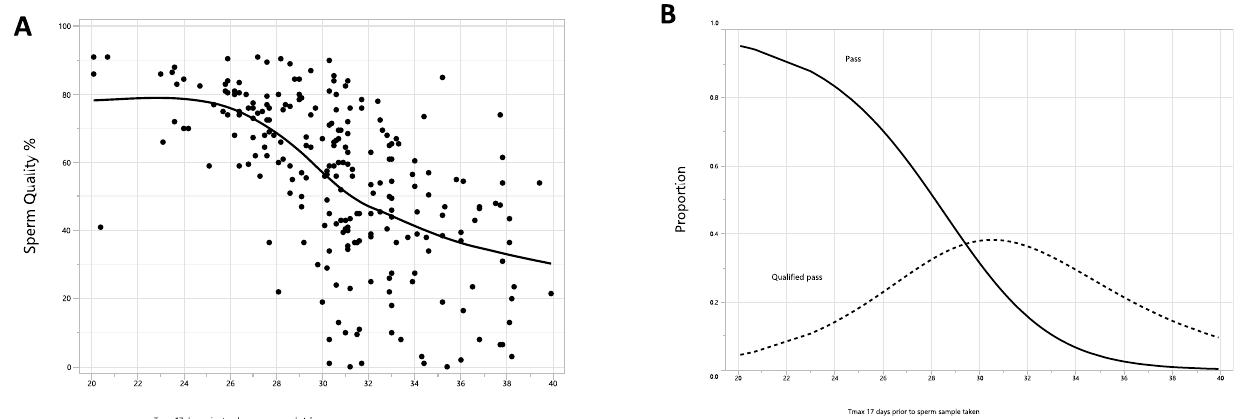
Figure 7. Sperm quality as a function of temperature 17 days prior. Sperm quality was evaluated for a subset of 12 heat-sensitive bulls in two ways, ( a ) quality as % for each sample taken ( b ) fitted lines from a logistic regression model estimating the proportion passing for two categories of sperm quality, a pass (quality 70% of better) and a qualified pass (quality 50% or better if pass